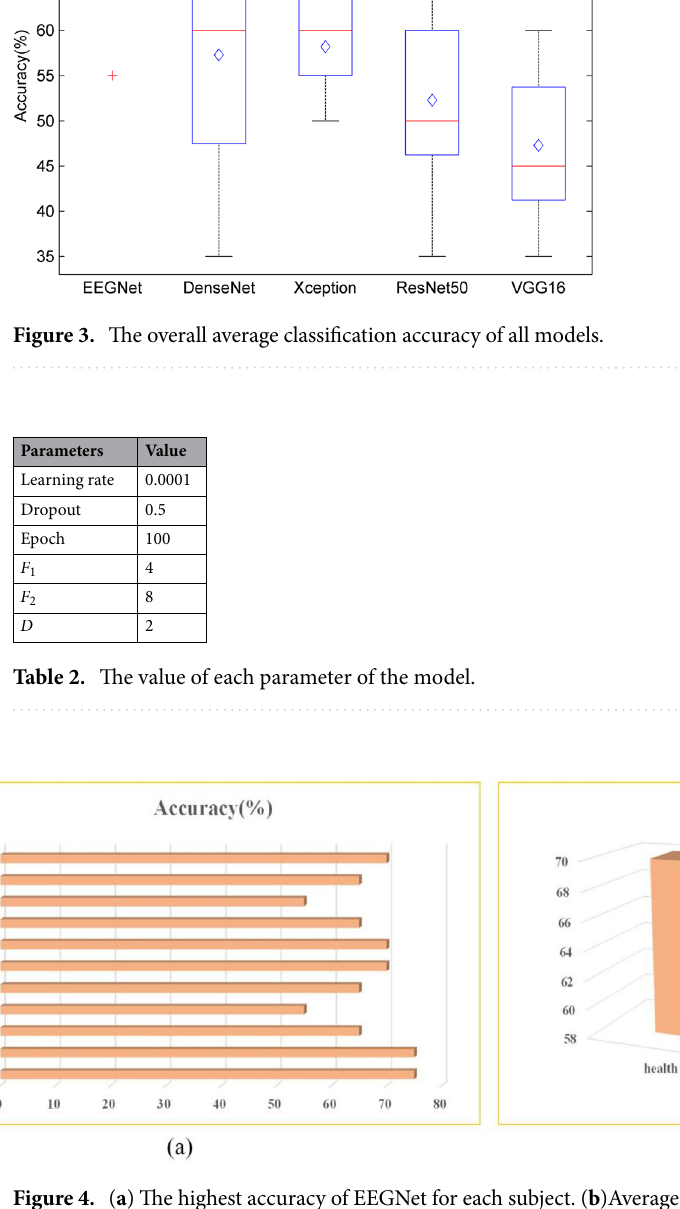
Figure 4. ( a ) The highest accuracy of EEGNet for each subject. ( b )Average accuracy of the two datasets (health and